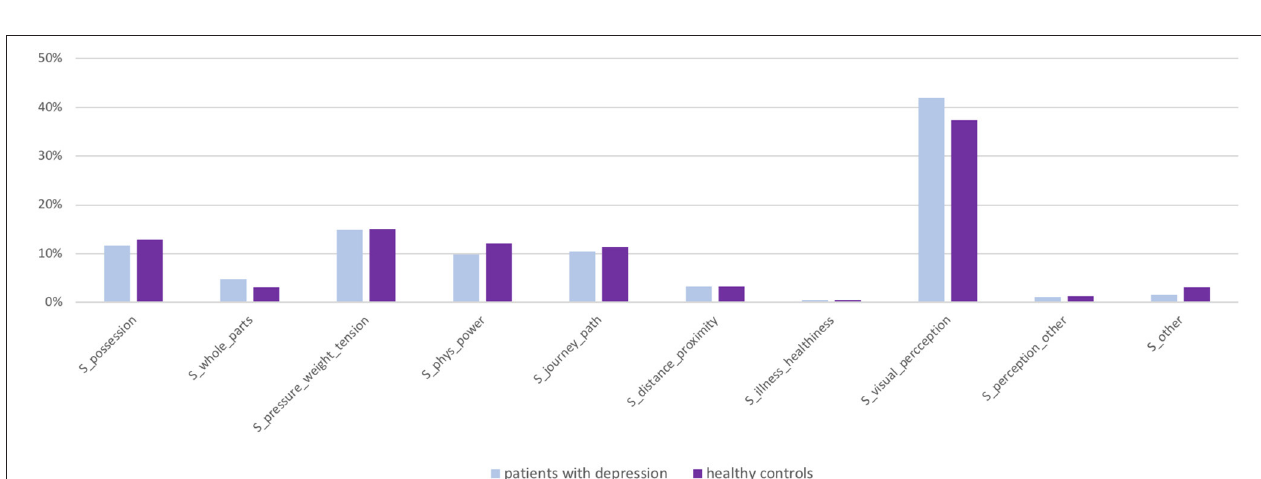
FIGURE 2 | Distribution of produced metaphor types in the elicited speech production task: group comparisons.